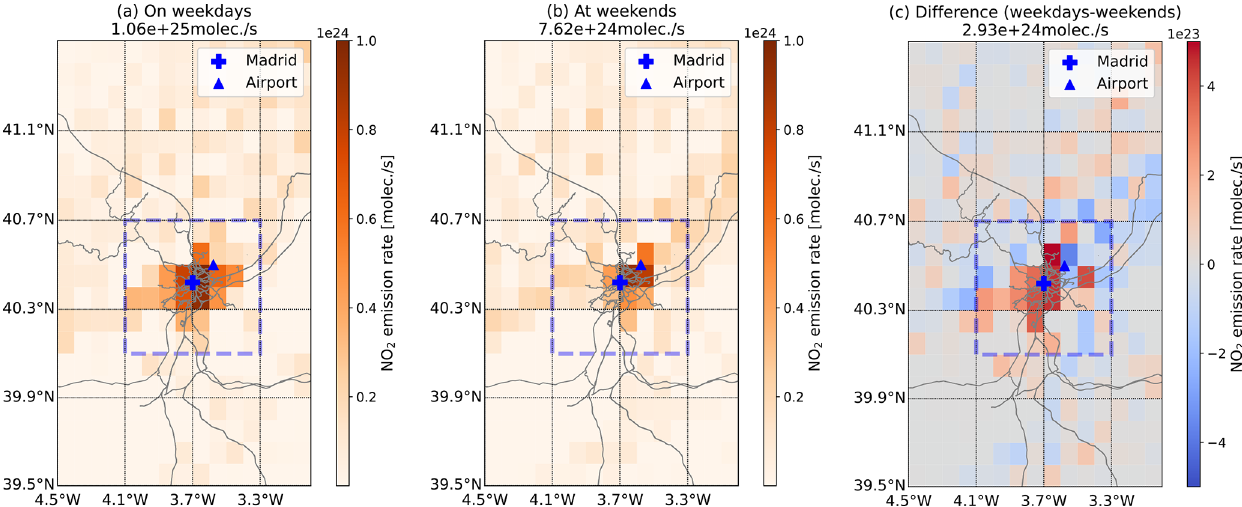
Figure 4. The same as Fig. 3 but for the Madrid area. The number in each panel heading presents the total emission rate in the dashed rectangle (70 × 70km 2